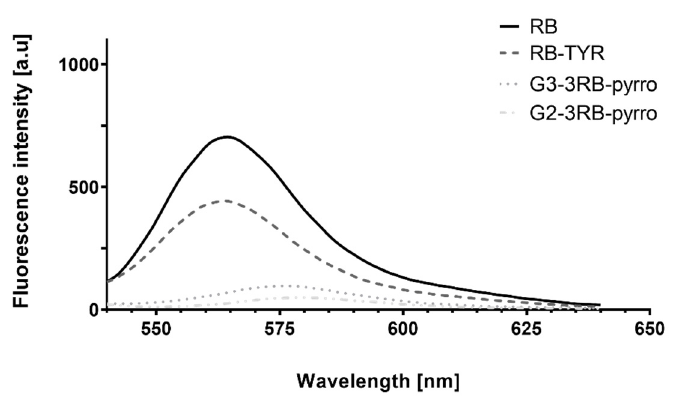
Figure 6. Fluorescence of rose bengal (RB), rose bengal modified with tyramine (RB–TYR) and conjugates of phosphorus dendrimers of the second and the third generation with three molecules of RB (G2–3RB–pyrro and G3–3RB–pyrro, respectively), dissolved in distilled water. Concentration of all compounds was calculated for RB and equaled 2.5 µ M. Due to the lack of fluorescence activity of the G1–3RB–pyrro conjugate, data are not shown. Excitation wavelength: 525 nm.